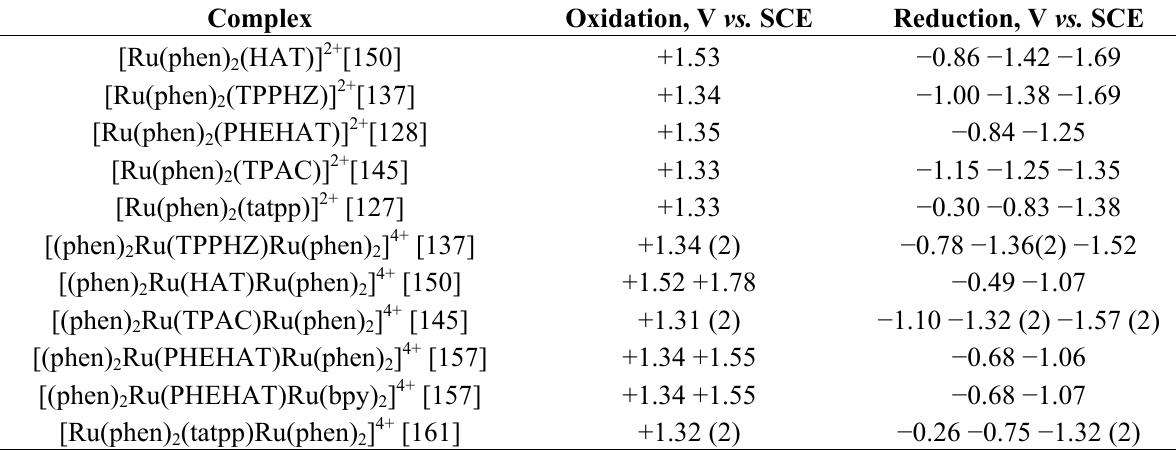
Table 10. Redox potentials measured by cyclic voltammetry in acetonitrile vs. SCE for specific mononuclear complexes and their related binuclear complexes. In parenthesis is the number of exchanged